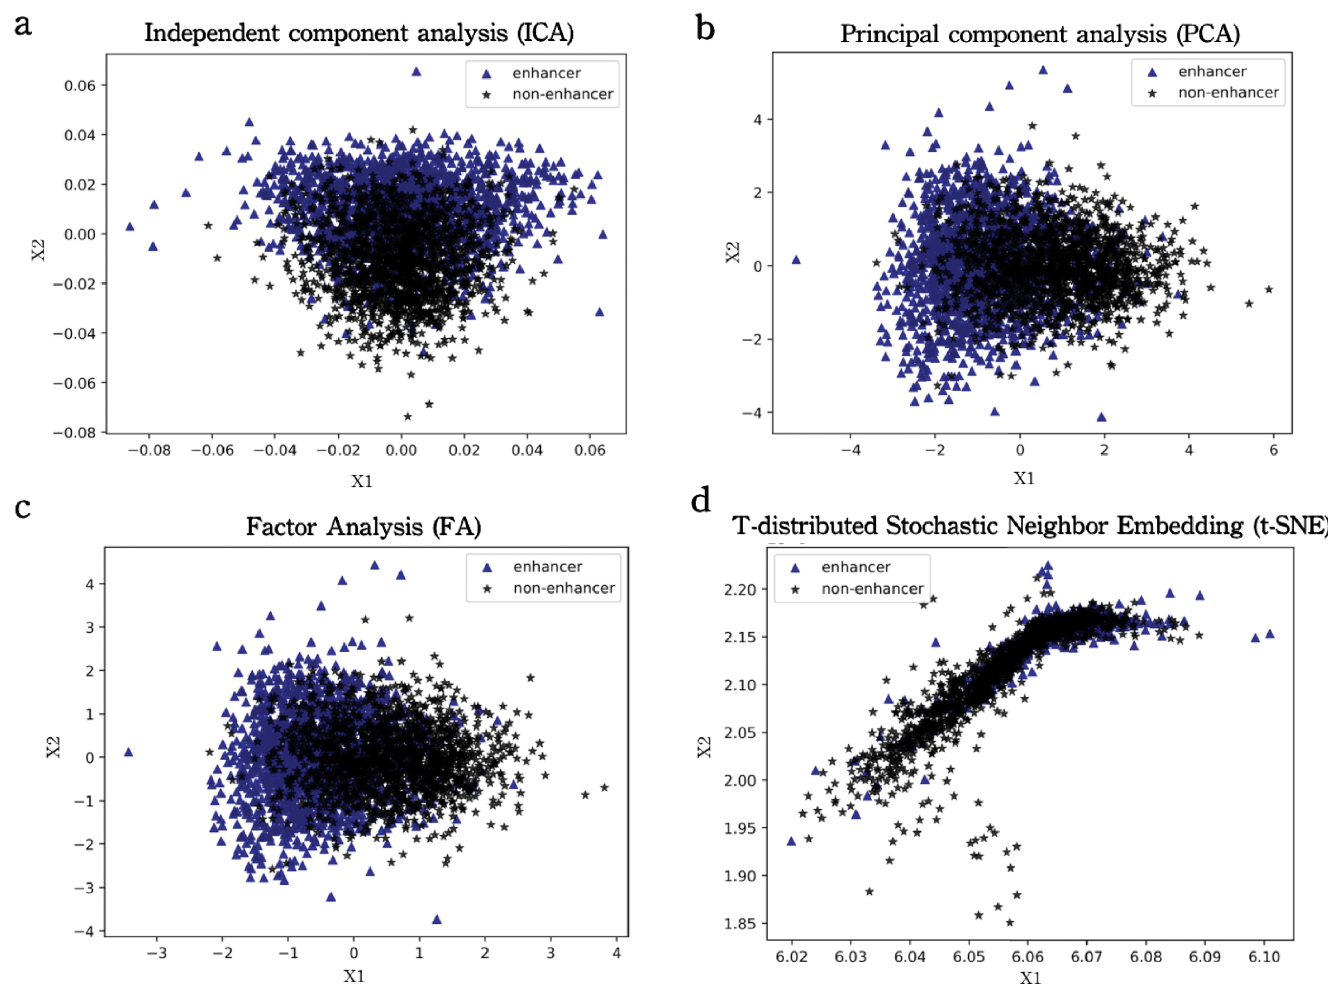
Fig 1. Dataset visualization for DNA Enhancers based on the one-hot encoding approach. All figures are drawn using dimensionality reduction methods including ICA, PCA, FA and t-SNE with Python scikit-learn package as default setting. From the figures it can be concluded that linear classification cannot be utilized in enhancer